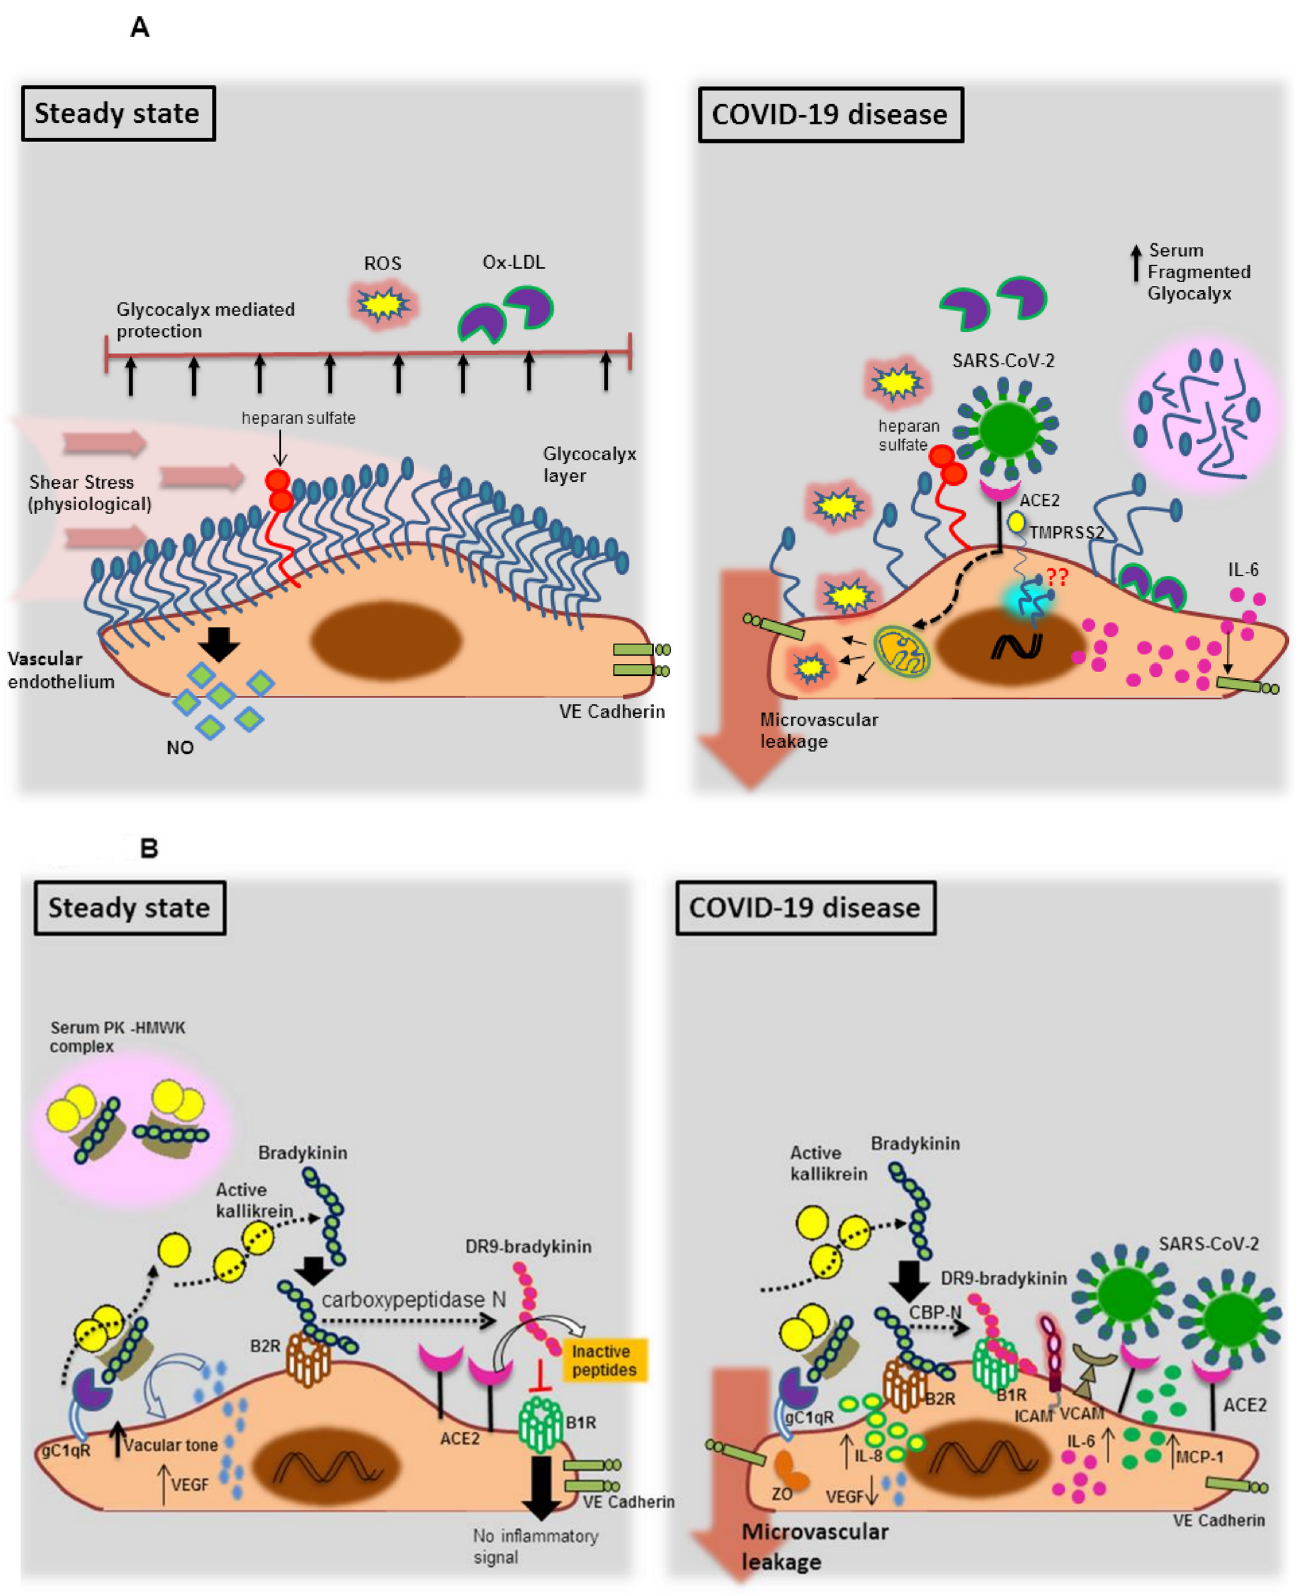
Figure 1. Potential molecular mechanisms underlying vascular leakage during SARS-CoV-2 infection. ( A ) Under the steady- state condition, vascular endothelium expresses qualitative and quantitative glycocalyx, which protects the endothelial damage with plasma-circulating ox-LDL and free oxygen radicals termed reactive oxygen species (ROS). In addition,